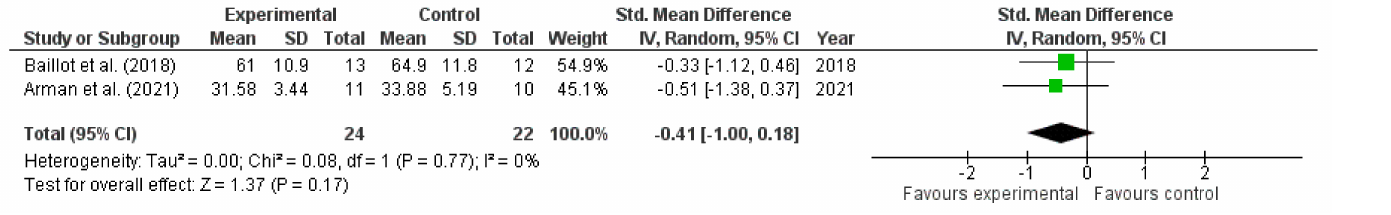
Figure 6. Forest plot of the body composition for the FFM Kg subgroup